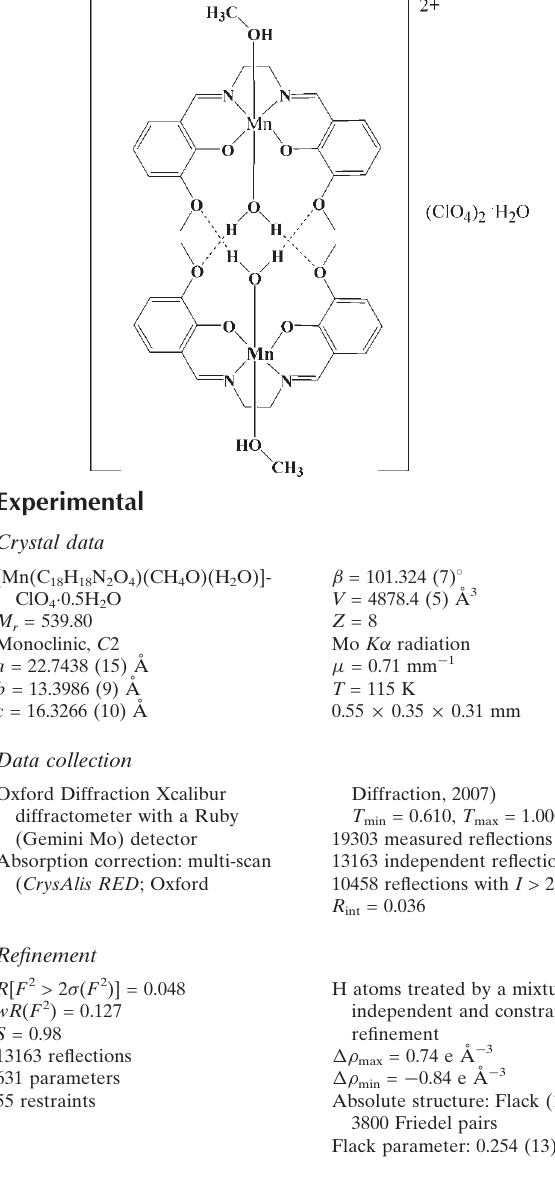
Diffraction, 2007) T min = 0.610, T max = 1.000